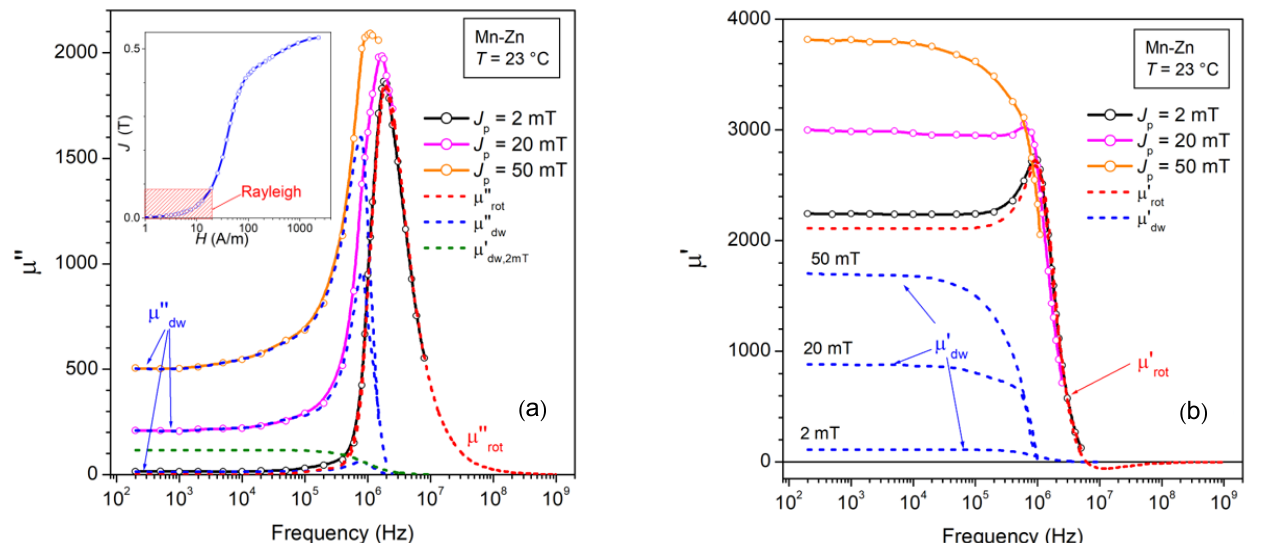
Figure 5. Imaginary ( a ) and real ( b ) permeabilities are decomposed into their dw and rotational contributions. The adopted procedure, carried out for J p values belonging to the Rayleigh region (see inset in Figure 5a), is illustrated and justified through Equations (14)–(24). μ ′ dw and μ ″ dw relax around 1–2 MHz, whereas μ ′ rot and μ ″ rot display behavior consistent with the unfolding of ferromagnetic resonance.